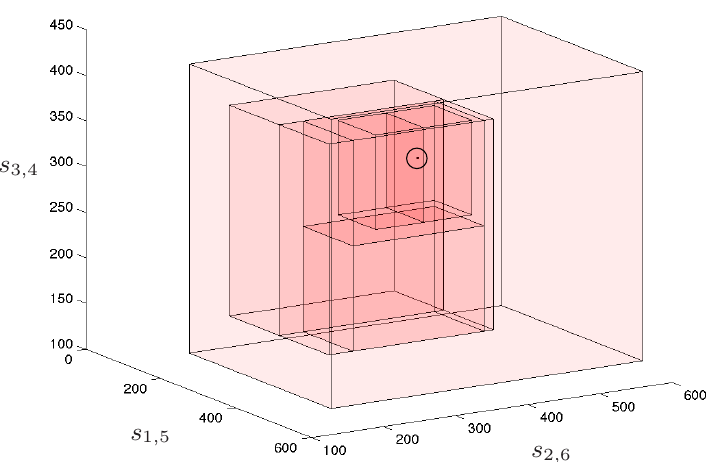
Figure 12. Solution of the direct kinematics of the octahedral manipulator obtained when considering orientation constraints.